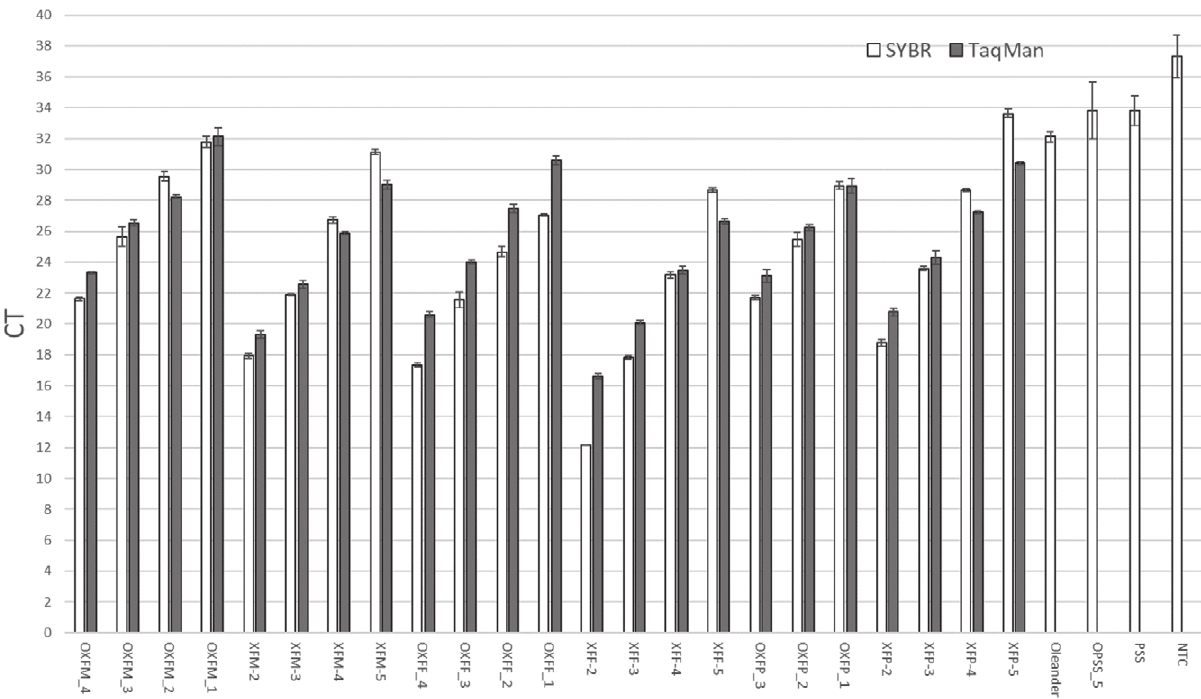
Figure 1. Results from qPCR Xylella fastidiosa detection assays. The graph shows different samples (Table 1) on the X-axis, and quantifica- tion cycles (Cq) obtained on the Y-axis. For each sample, the grey bars are results of TaqMan assays (Harper et al. , 2010) while the white bars are results of the SYBR Green assay (Francis et al. , 2006). The represented number for each Cq is the average obtained from three repli- cates, and the error bar represents the standard deviation. Where no bar is present, the result of the assay was